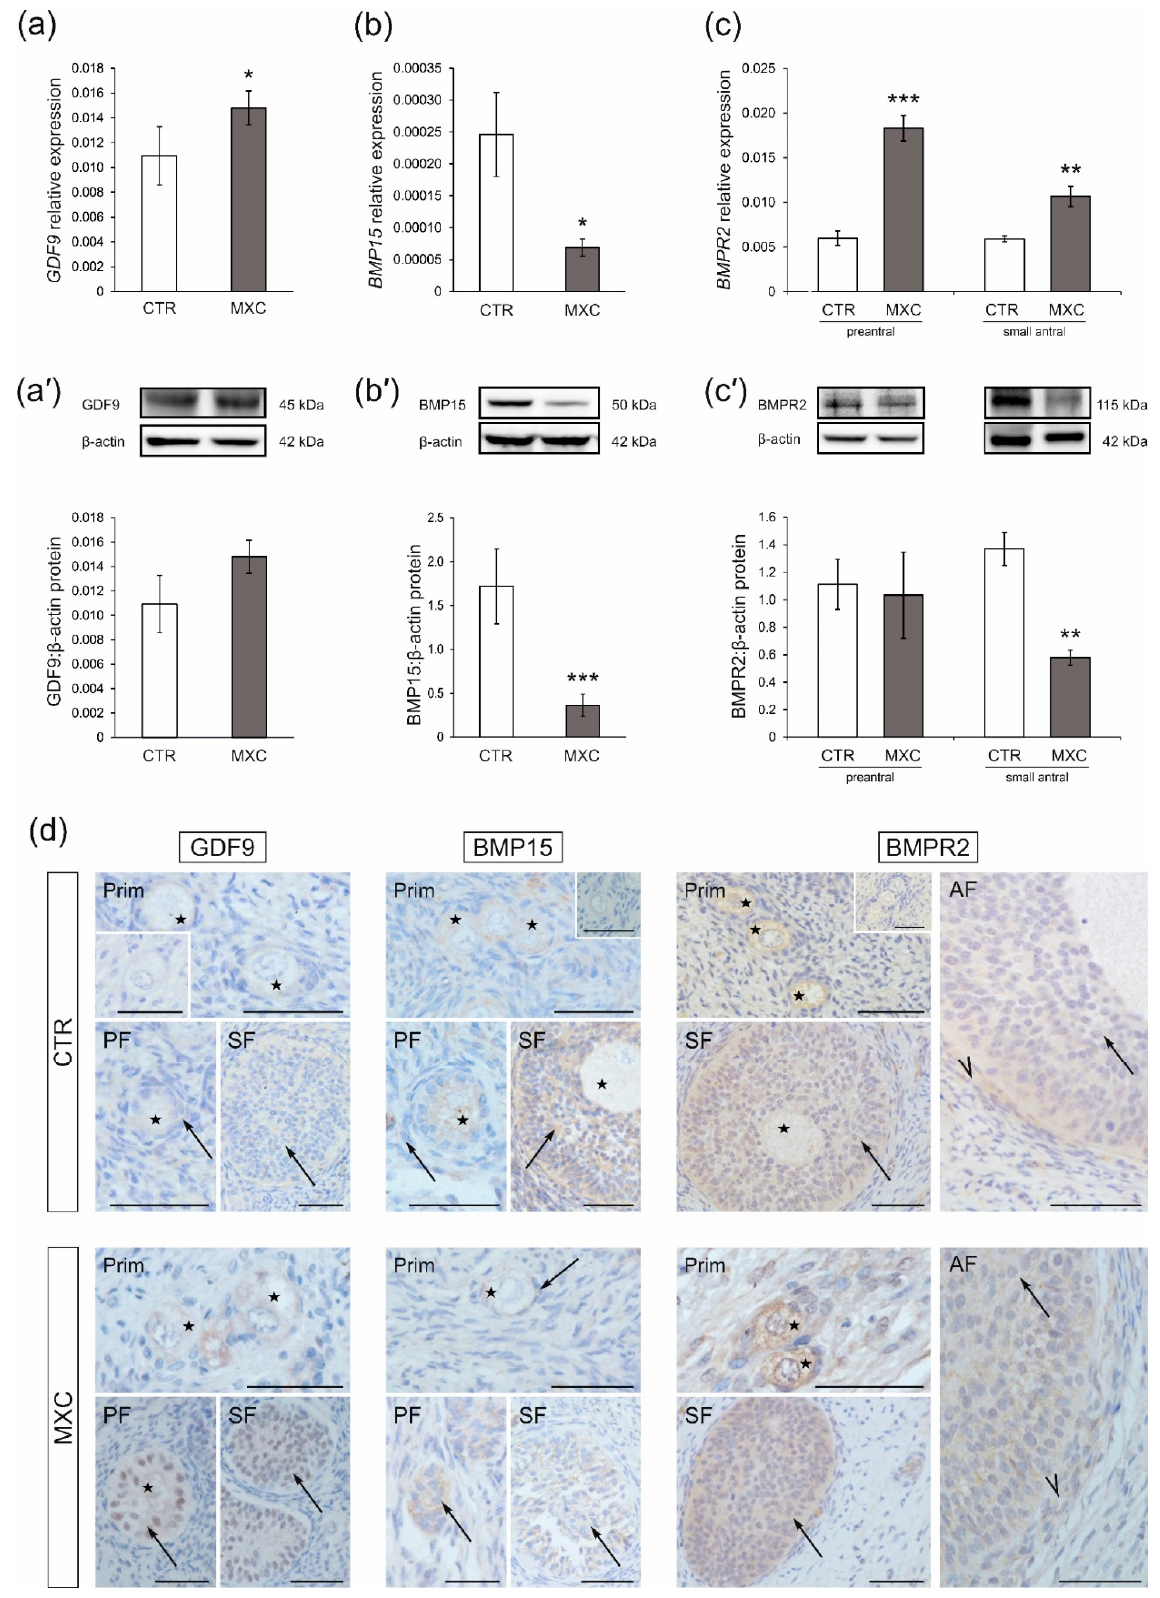
Figure 1. The mRNA expression and protein abundance of GDF9 ( a , a’ ), BMP15 ( b , b’ ) in preantral follicles, as well as BMPR2 ( c , c’ ) in preantral and small antral follicles obtained from the control (CTR) and methoxychlor (MXC-) treated gilts. The mRNA expression (quantitative real-time PCR) is